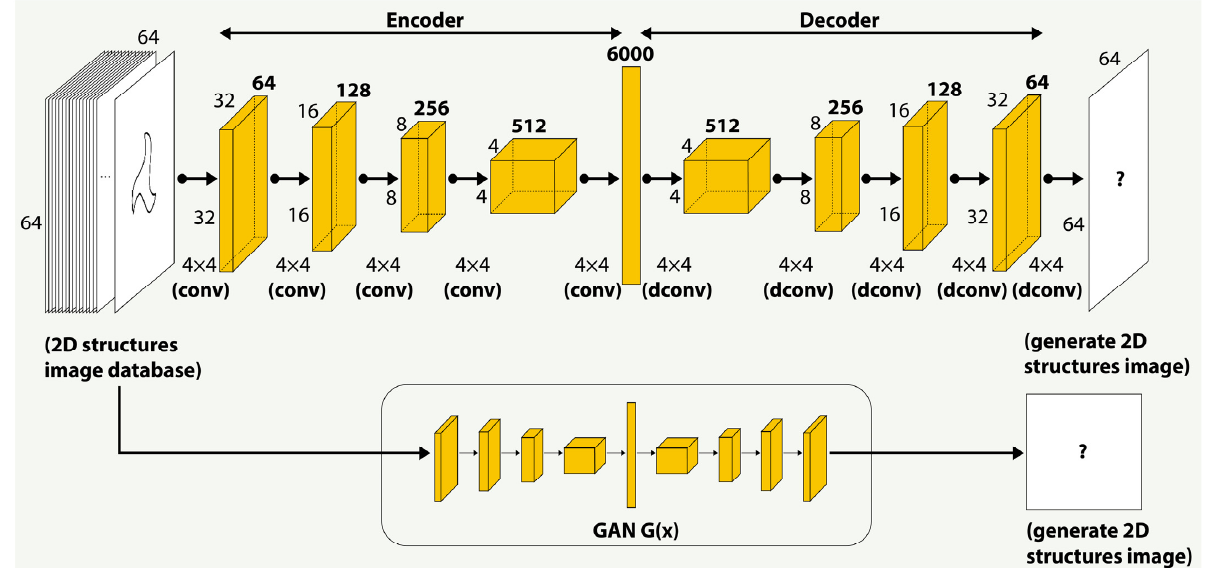
Figure 11. Schematic diagram of generating adversarial network (GAN) model (using 2D structural unit cells database to generate 2D structure as an example).